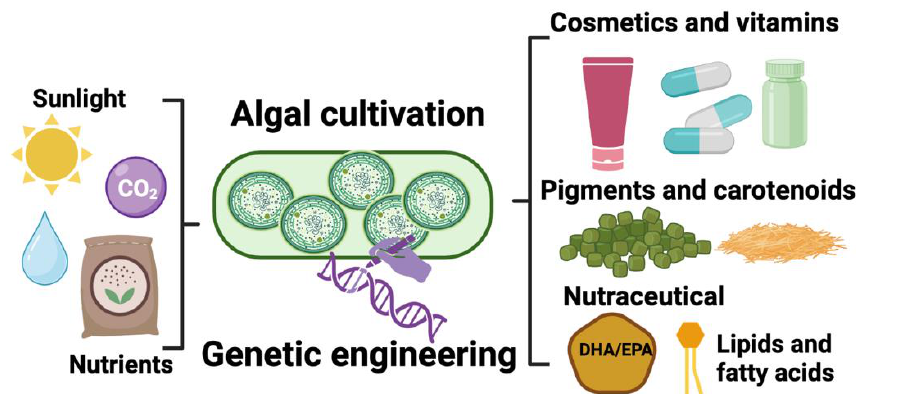
Figure 1. Synthesis of value-added products using algal strains.